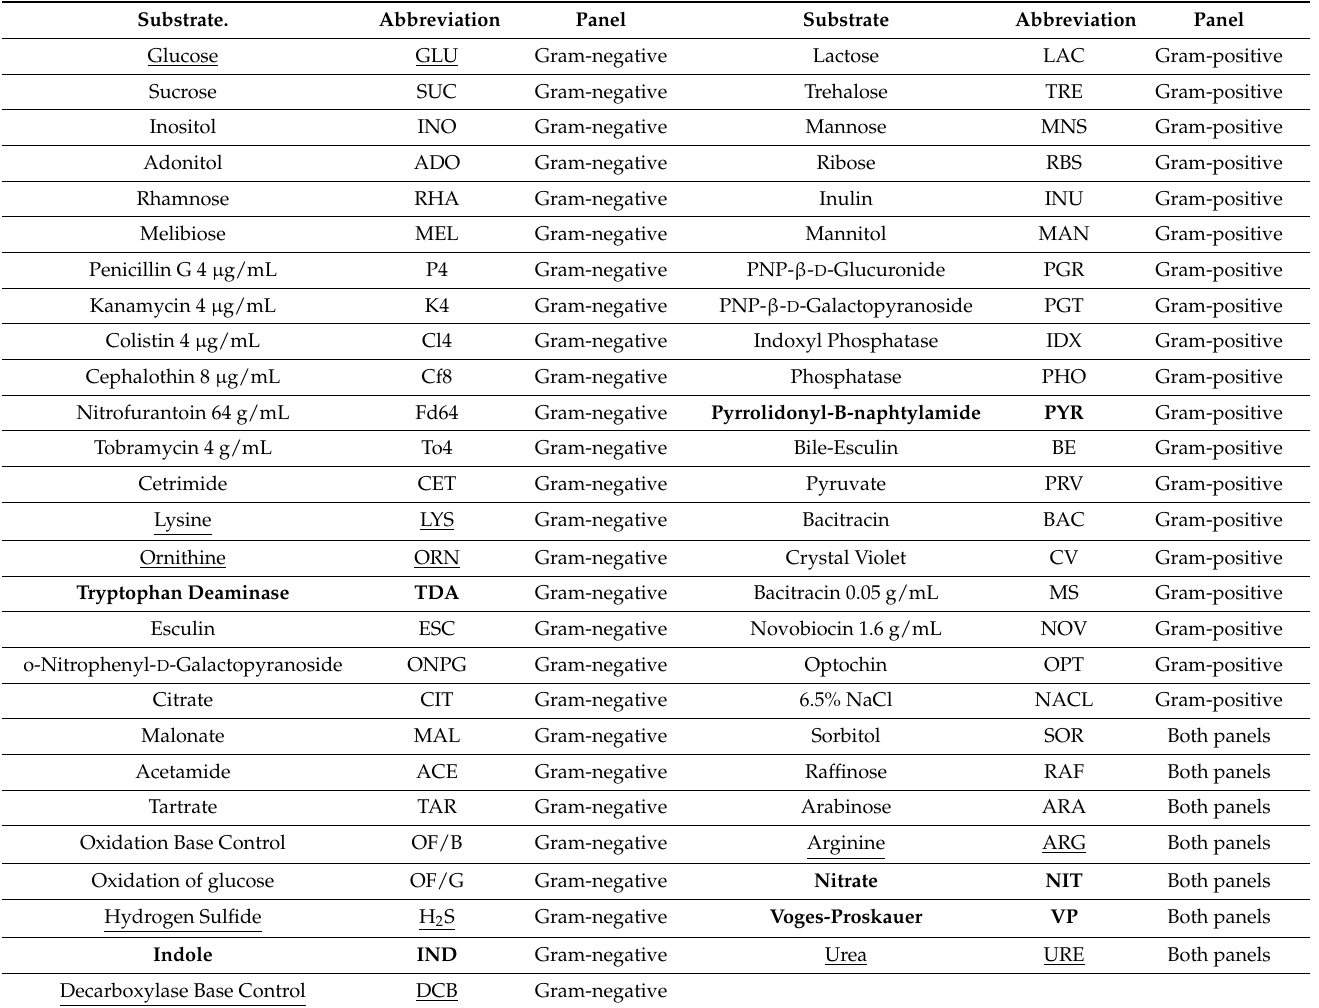
Table 1. Test wells on the MicroScan Gram-positive and Gram-negative panels (Dried Overnight Positive ID Type 3 (PID3) and Dried Overnight Negative ID Type 2 (NID2), respectively) or embedded in the customized MSF panel (MSFNPID1) and reagents to be added. Underlined substrates are wells for which coverage with mineral oil before incubation is needed after inoculation. Substrates in bold are tests for which additional reagents need to be added after incubation and before reading.